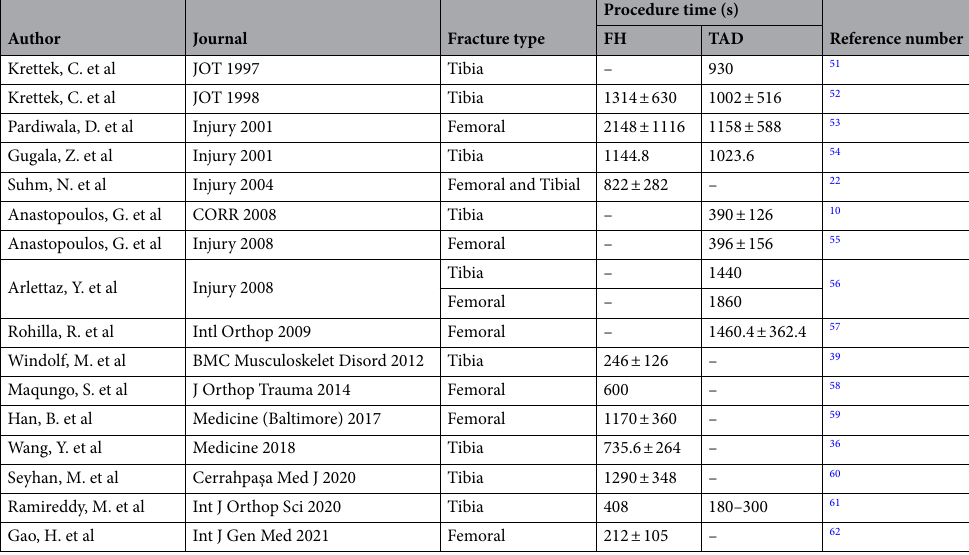
Table 5. Different reported procedure times for the free hand technique (FH) and the targeting-arm devices (TAD).